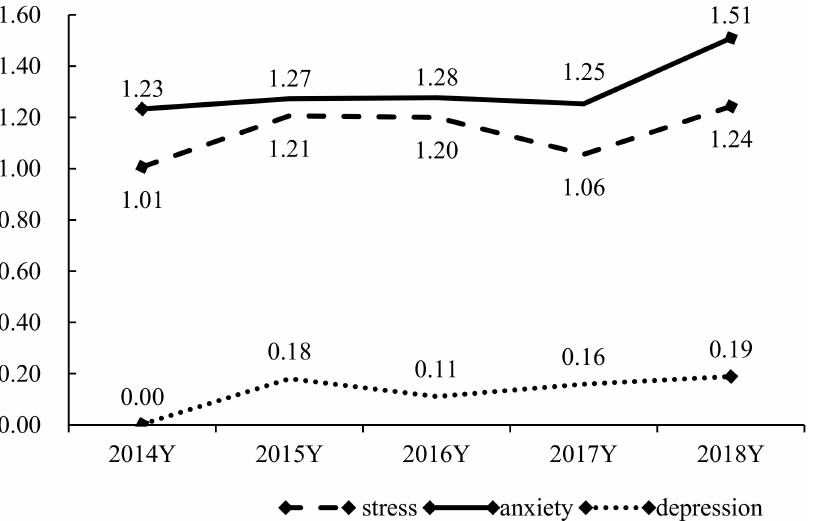
Figure 1. The trends of depression, anxiety, and stress from 2014/15 to 2018/19 academic years. Note. Latent means in each year have been indicated in this figure.